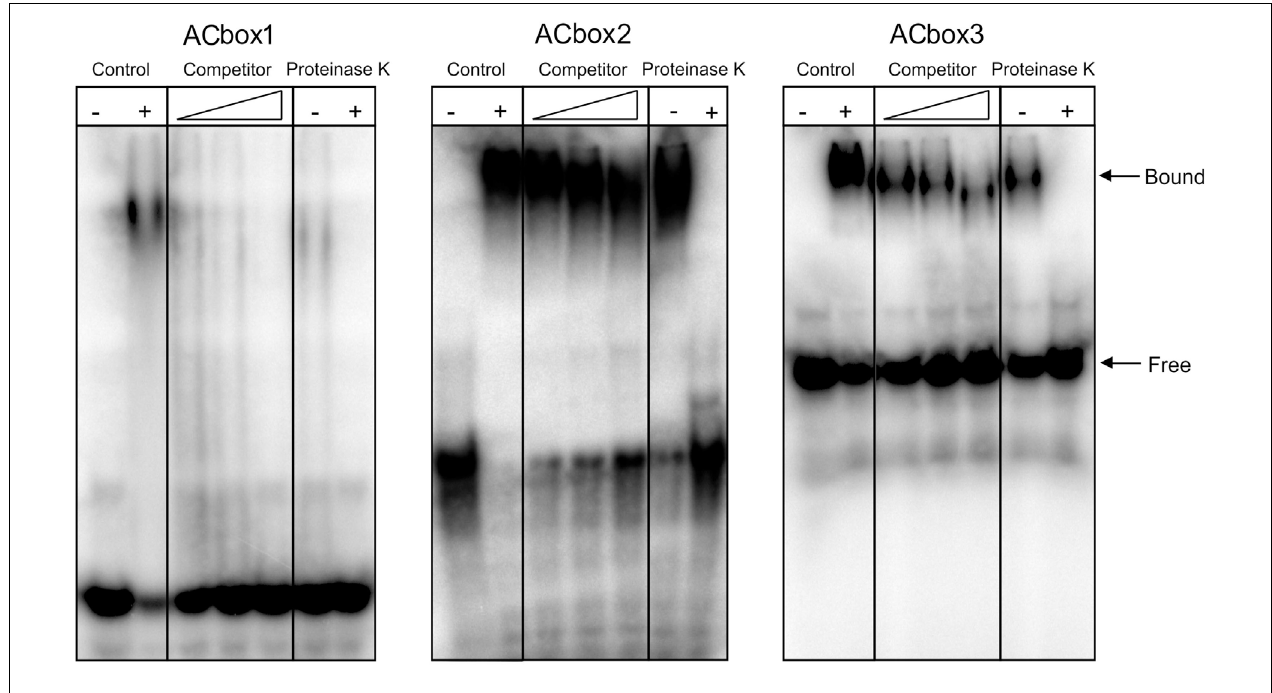
FIGURE 6 |Analysis of the interaction between PtMYB1 and the PpAS1 promoter. Experiments of PtMYB1 binding with specificity control tests. Competition experiment was performed using increasing